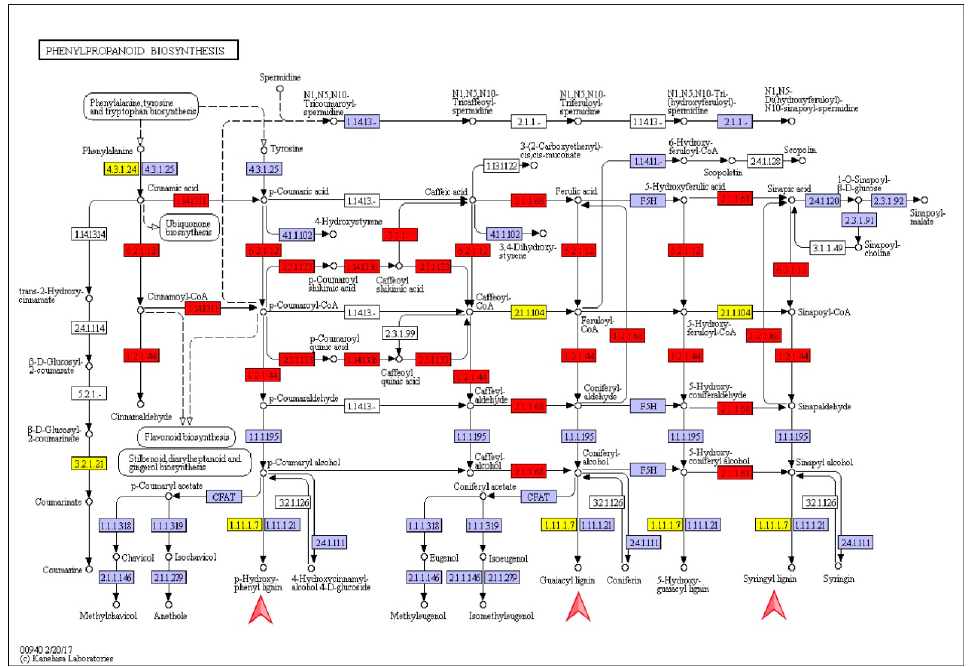
Figure 8. Pathway assignments based on the Kyoto Encyclopedia of Genes and Genomes (KEGG). A schematic representation of the phenylpropanoid biosynthesis pathway. The number in the rectangle indicates the corresponding enzyme. Red indicates upregulated unigenes, green indicates downregulated, yellow indicates unigenes that were both up- and down-regulated, and gray indicates no DEGs. Red arrows indicate H-type lignin, G-type lignin, and S-type lignin, respectively.